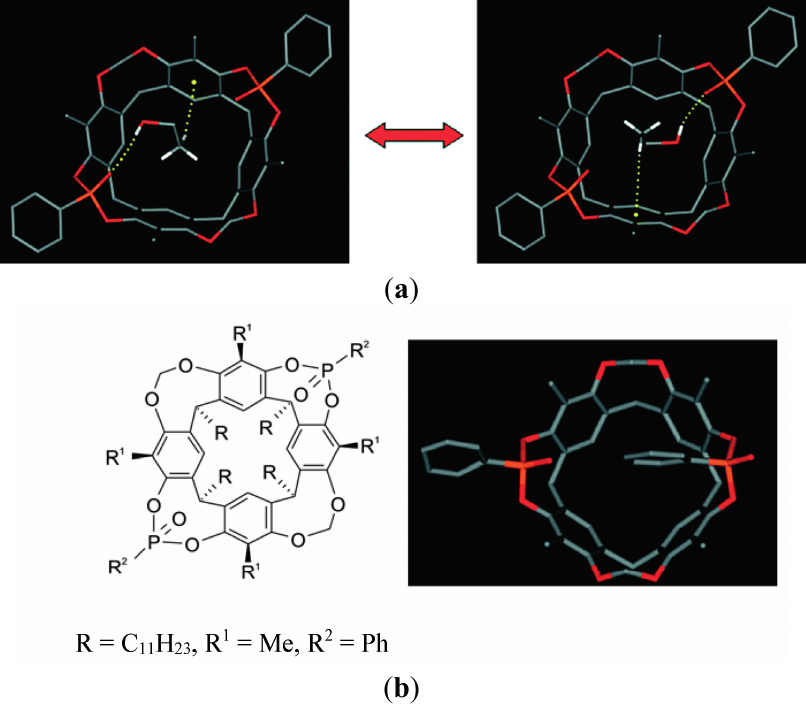
Figure 13. ( a ) Resorcarene complexes with ethanol exhibiting two different structures within one crystal (hydrogen bonds of EtOH with the two distal P=O groups with a 50% statistical probability); ( b ) isomeric structure with a phenyl group filling the cavity; ethanol can only bind outside the cavity [50]. Reprinted from ref. [50] with permission of the Royal Society of Chemistry.